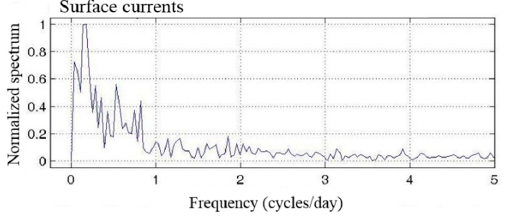
Figure 7. Frequency spectrum of the surface current parallel to the coastline.